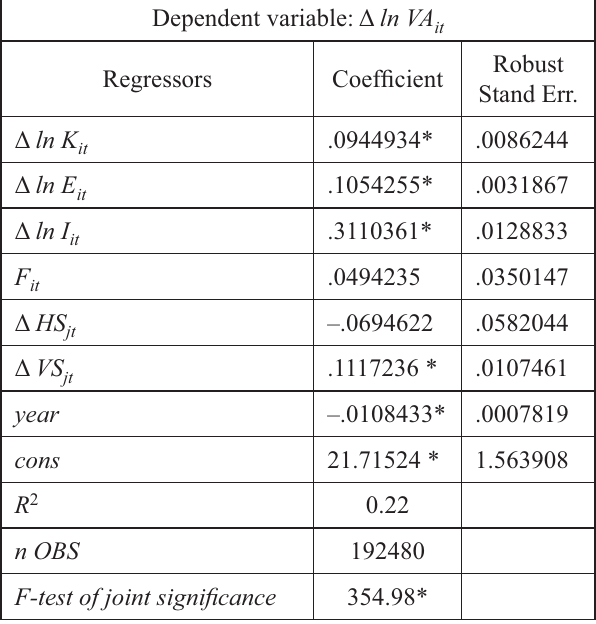
Table 3.3. Results of the Fixed Effects estimation of model